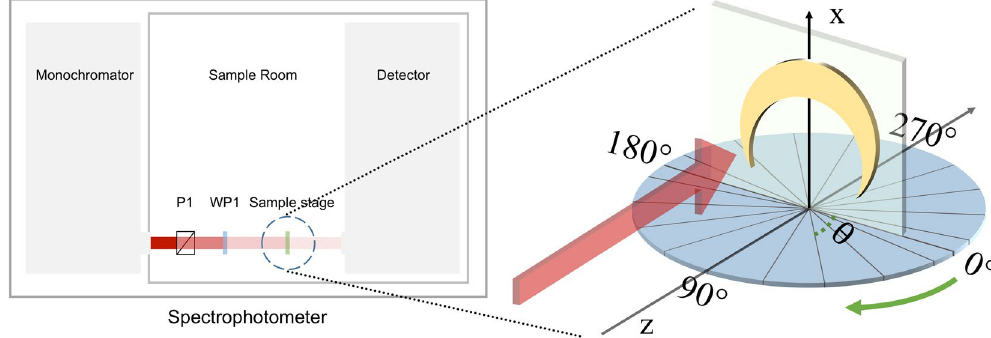
Figure 4. Schematic design of the experiment. Here, P1 stands for glan-taylor prism as a polarizer and WP stands for a wideband quarter-wave plat. The inset shows that the sample is mounted on a rotational micropositioning